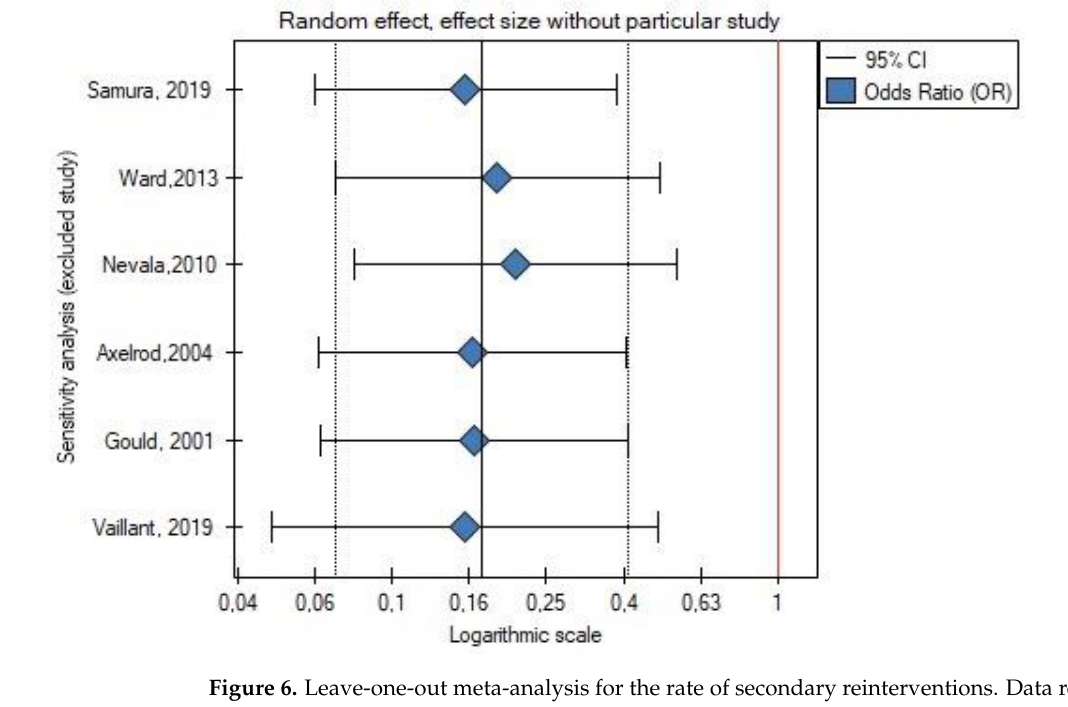
Figure 6. Leave-one-out meta-analysis for the rate of secondary reinterventions. Data referred from reference [22 – 27].